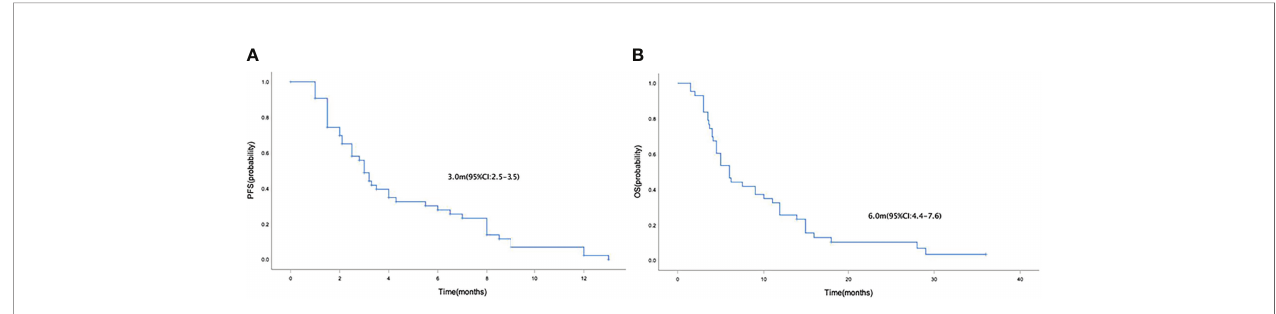
FIGURE 2 | Kaplan-Meier curve of PFS (A) and OS (B) in the general